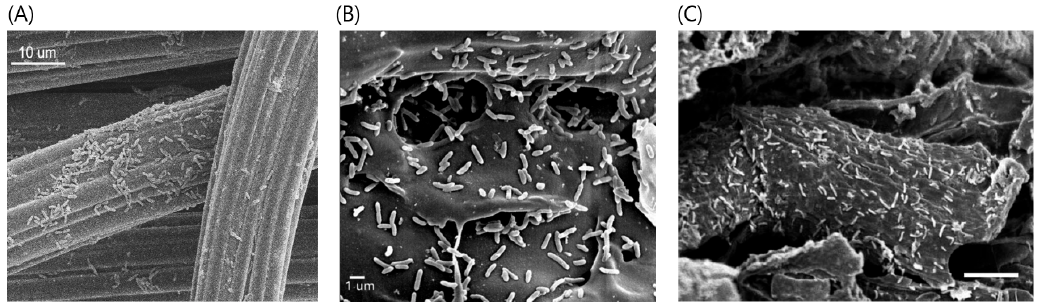
Figure 3. Physical contact between conductive materials and microorganisms for ( A ) carbon cloth (adapted from Chen et al. [11]), ( B ) biochar (adapted from Chen et al. [12]), and ( C ) activated carbon (adapted from Liu et al. [14]).